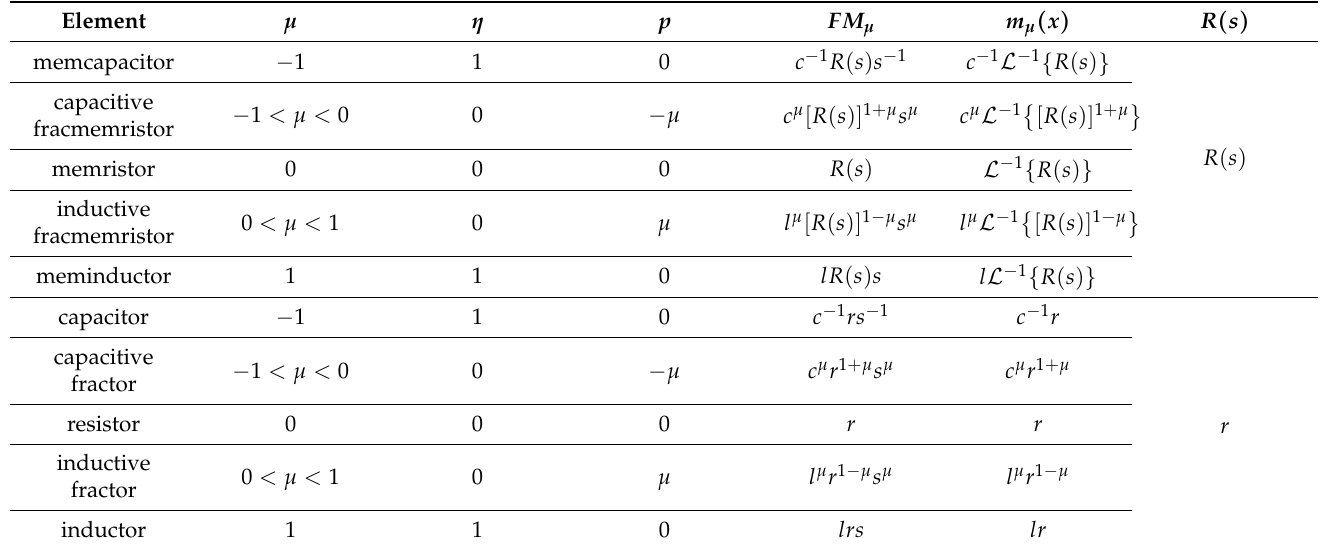
Table 1. Equations (1) and (2) are the types of elements that can be